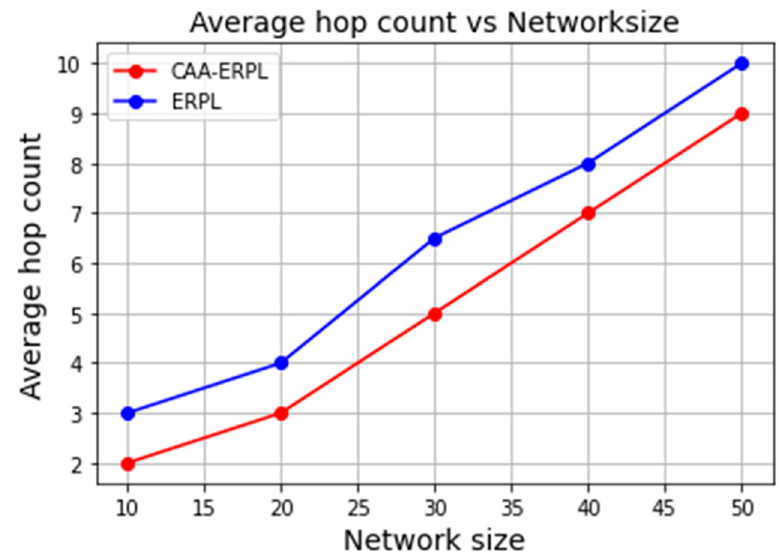
Figure 5. Average hop count vs. network size.